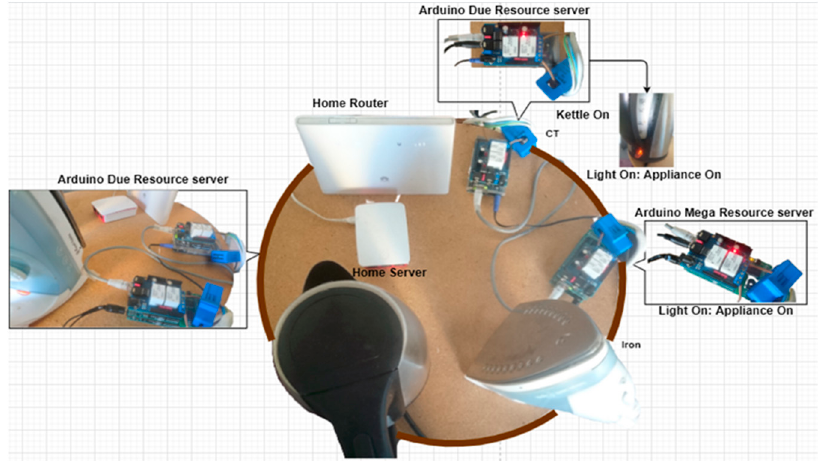
Figure 6 . Experimental setup under evaluation . Figure 6. Experimental setup under evaluation.